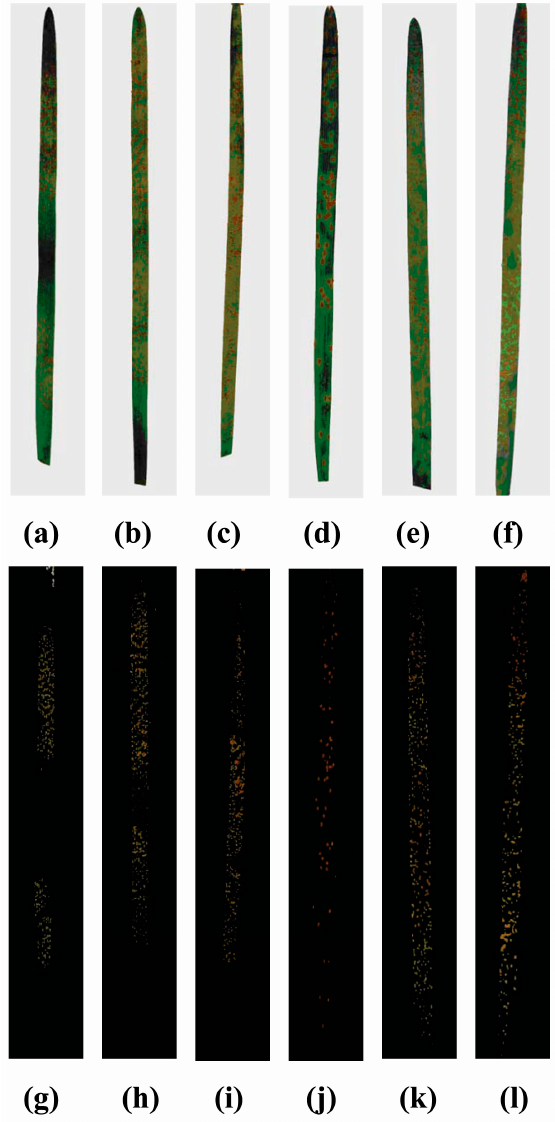
Figure 3. The original single-diseased-leaf images and the corresponding segmented color lesion images of wheat stripe rust and wheat leaf rust on different varieties, acquired under laboratory environmental conditions. For a clear demonstration, all the images are shown after being uniformly cropped. ( a – c ) are the original single-diseased-leaf images of wheat stripe rust on wheat varieties Beijing 0045, Mingxian 169, and Nongda 211, acquired under laboratory environmental conditions, respectively; ( d – f ) are the original single-diseased-leaf images of wheat leaf rust on wheat varieties Beijing 0045, Mingxian 169, and Nongda 211, acquired under laboratory environmental conditions, respectively; ( g – i ) are the segmented color lesion images of the single-diseased-leaf images of wheat stripe rust on wheat varieties Beijing 0045, Mingxian 169, and Nongda 211, acquired under laboratory environmental conditions, respectively; and ( j – l ) are the segmented color lesion images of the single-diseased-leaf images of wheat leaf rust on wheat varieties Beijing 0045, Mingxian 169, and Nongda 211, acquired under laboratory environmental conditions, respectively.